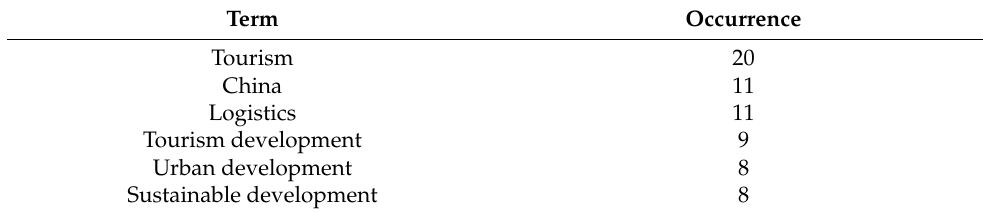
Table 1. The most common terms in the pool under analysis.